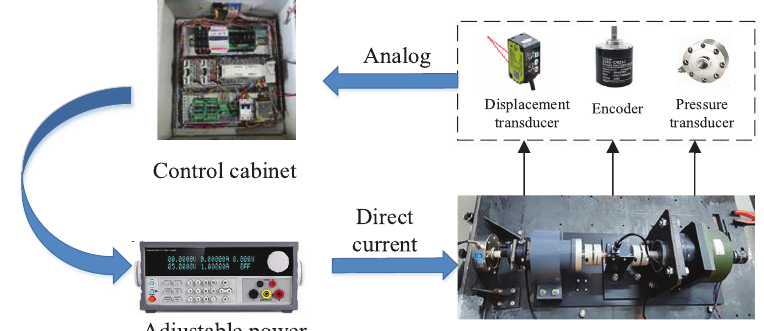
Fig. 3. Electro-mechanical braking system test bench.